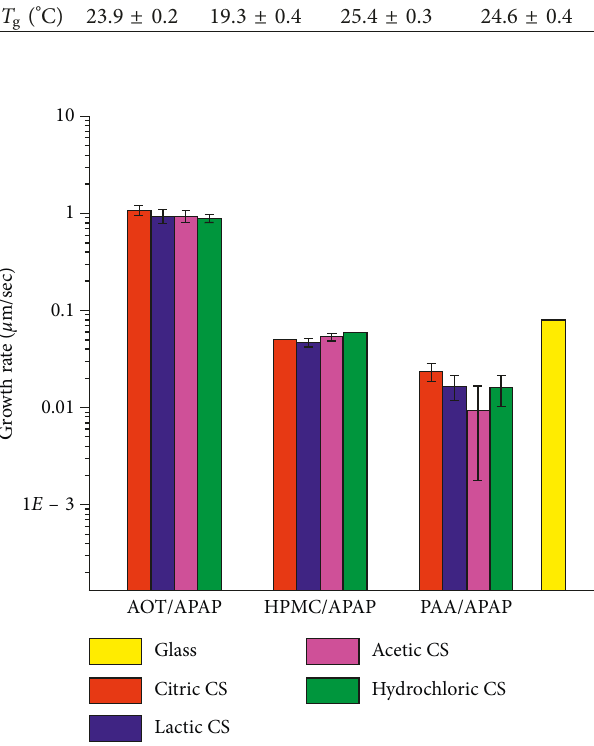
Figure 9: Growth rate of 5% additive/APAP on CS films without being